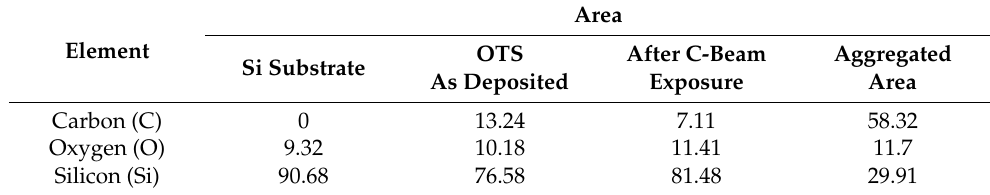
Table 2. Summary of EDAX atomic analysis of various substrates with electron beam exposure.